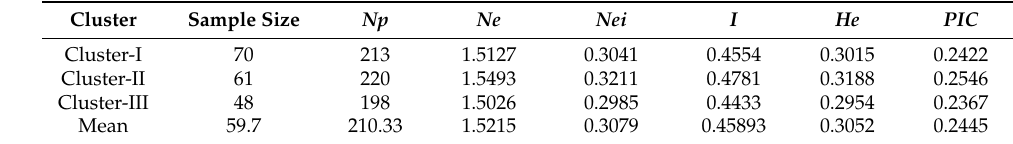
Table 7. Marker–trait associations identified through the general linear model (GLM) and mixed linear model (MLM).